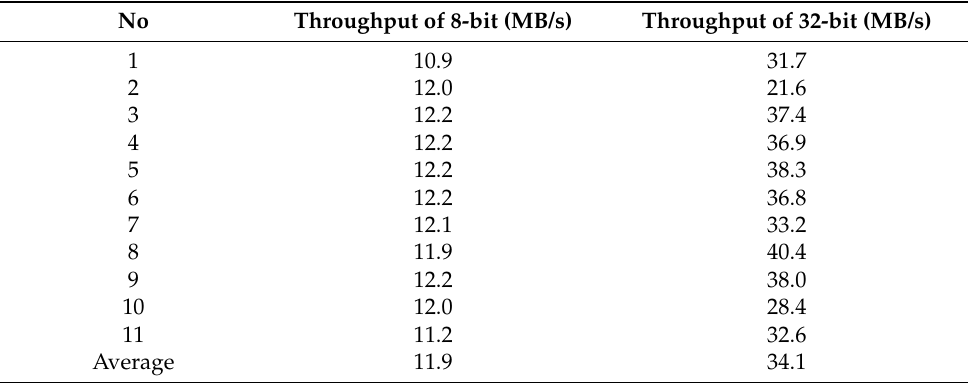
Table 2. Throughput between the 8-bit width access and the 32-bit width access.